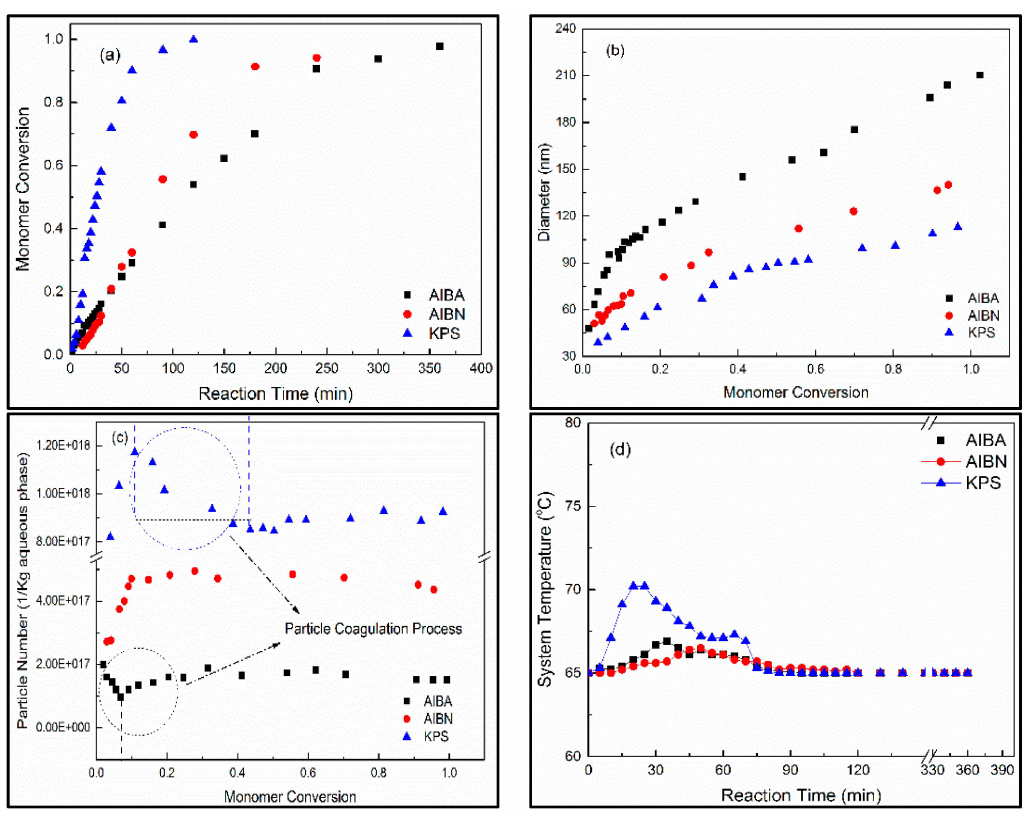
Figure 7. Plots of the monomer conversion ( a ); particle size ( b ); particle number ( c ); and system temperature ( d ) against monomer conversion (or reaction time) for the emulsion polymerization of styrene using methanol solution (20/80 w / w ) as the polymerization medium and various types of